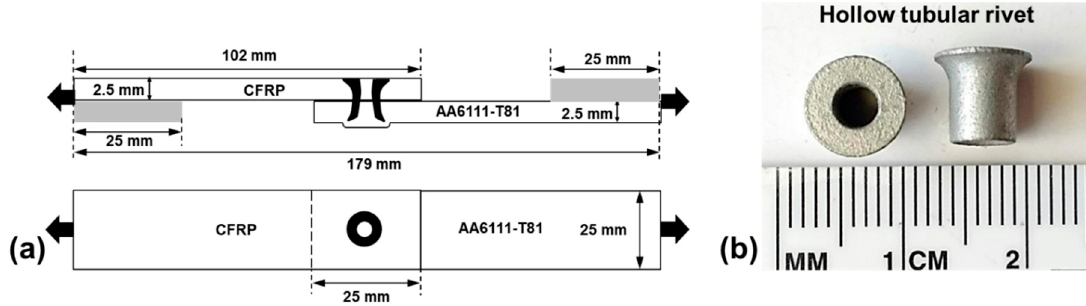
Figure 1. ( a ) Schematics illustrating the geometric values of lap-shear self-piercing rivet (SPR) joints, and ( b ) representative of a hollow rivet employed in this and ( b ) representative of a hollow rivet employed in this study.